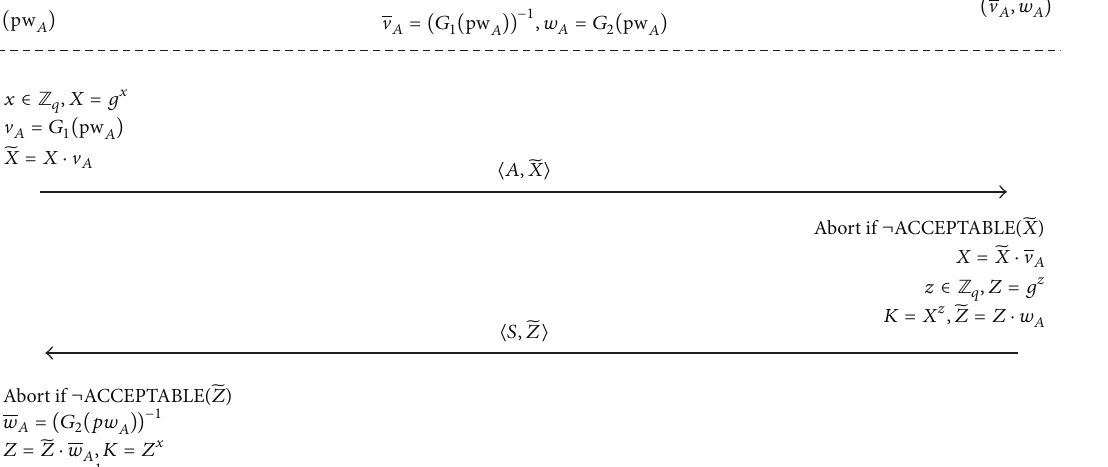
Figure 2: The PPK protocol [32].